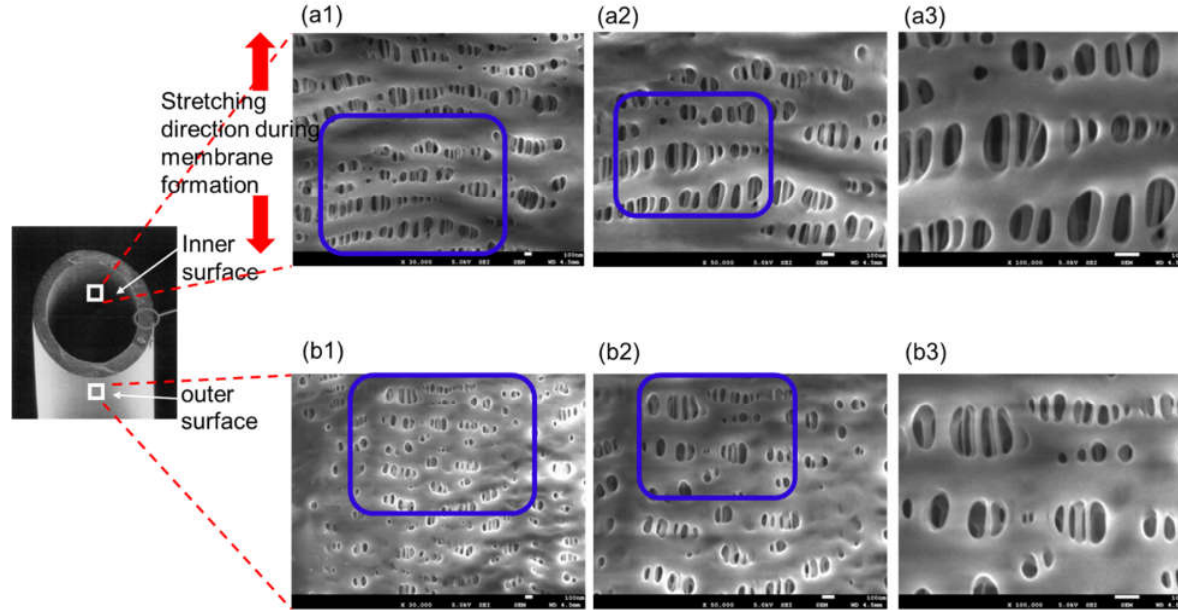
Figure 3. FE-SEM images of oxia ® (dry), ( a ) the surface of inner lumen of the capillary membranes, ( b ) the outer surface of the capillary membranes: (1) ×30,000; (2) ×50,000; and (3) ×100,000, respectively. The image of (3) shows magnified images of the pores enclosed by the blue square in (2), and the image of (2) shows magnified images of the pores enclosed by the blue square in (1).